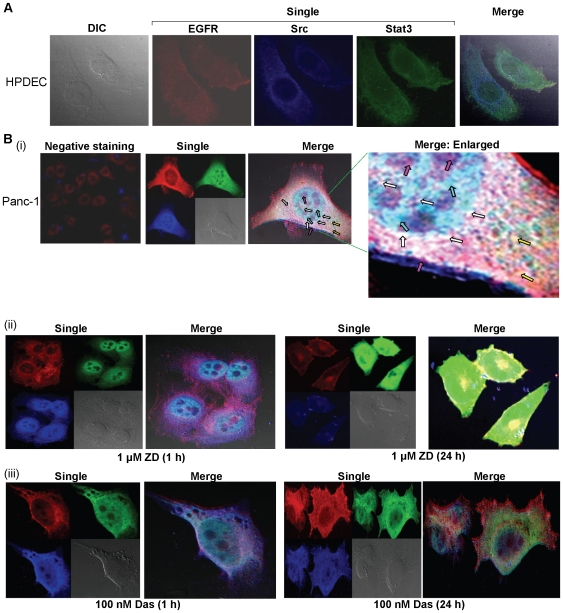
Immunofluorescence with laser-scanning confocal microscopy of EGFR, Src and Stat3 association in HPDEC or Panc-1 cells.Cultured normal human pancreatic duct epithelial cells (HPDEC) (A) or pancreatic cancer, Panc-1 cells (B) were fixed, stained with primary antibodies against EGFR, Src and Stat3 and their corresponding secondary antibodies, ALexaFLuor405 (goat anti-mouse, EGFR, red), AlexaFluor488 (donkey anti-rabbit, Src, blue) and AlexaFluor546 (goat anti-rat, Stat3, green) and analyzed by laser-scanning confocal microscopy for localization (single) and colocalization (merge) studies of EGFR (red), Src (blue) and Stat3 (green) and the effects of treatment (i) without or (ii) with ZD1839 (ZD) or (iii) Dasatinib (Das) for the indicated times. Confocal images were collected using Leica TCS SP5 microscopes; Cyan, magenta, yellow and white/pale yellow arrows denote merged colors; single, one color capture, merged, three-color capture. Data are representative of 3 independent studies.